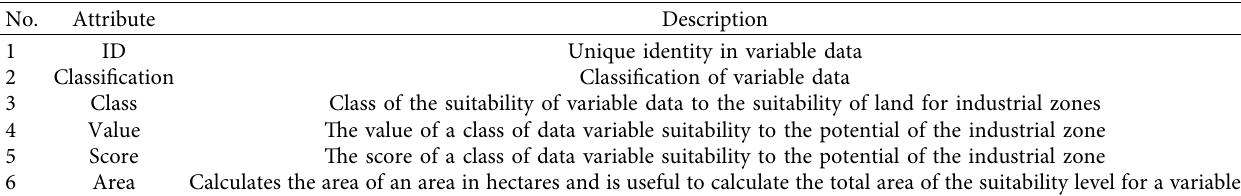
Table 1: Data variable identification.